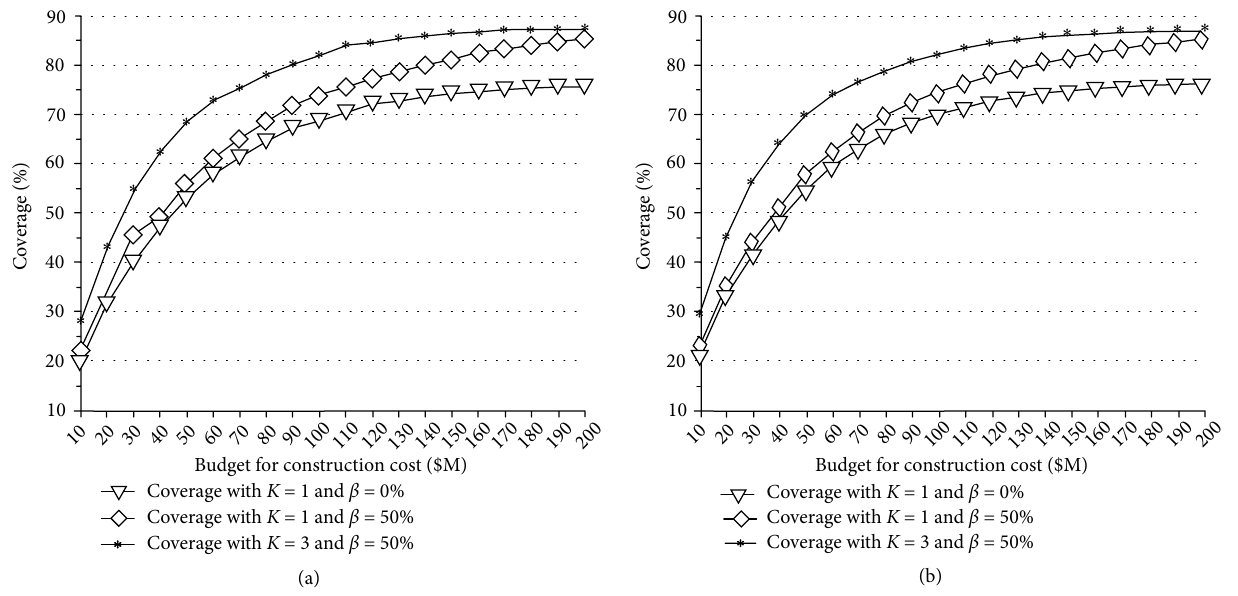
% ) versus detour flows ( 훽 = 0